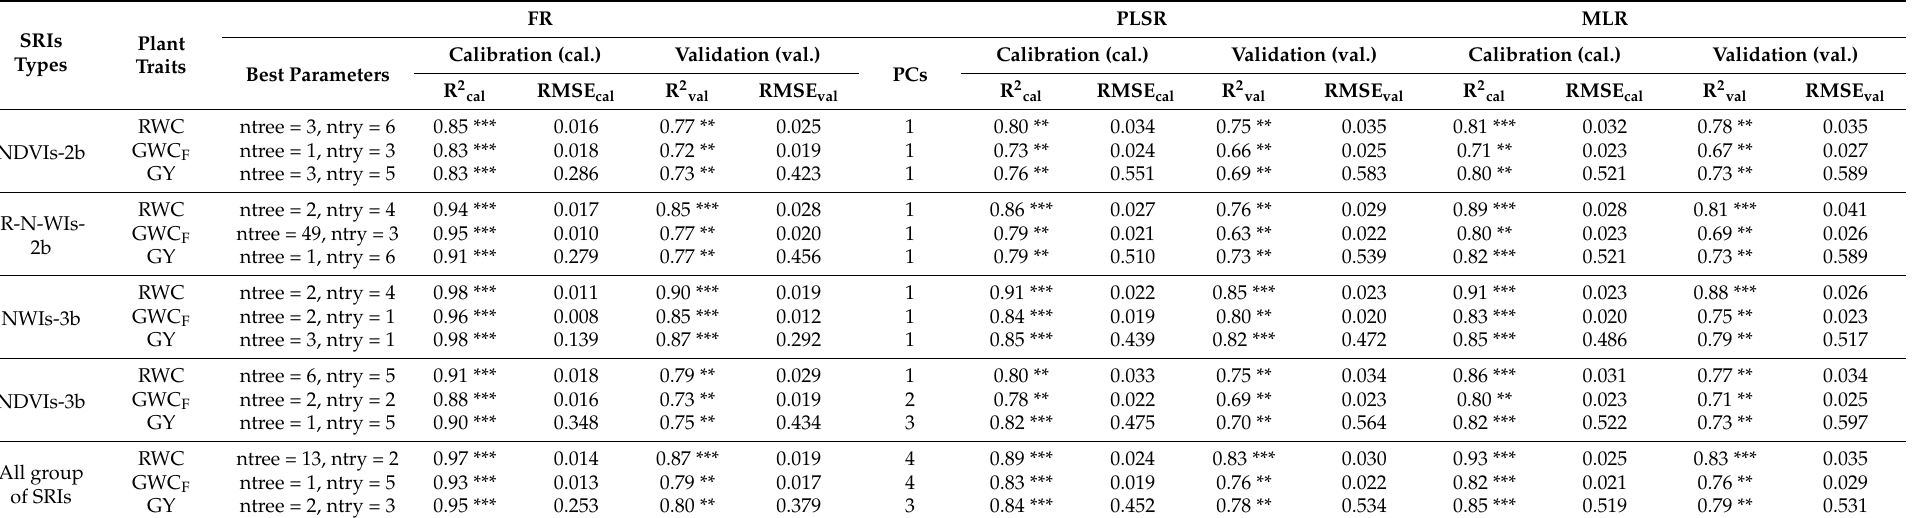
Table 4. Results of coefficient of determination (R2) and root mean square error (RMSE) of the calibration (Cal.), and ten-fold cross-validation (Val.) for the random forest (RF), partial least square regression (PLSR), and multiple linear regression (MLR) models of the relationship between the spectral reflectance index types and relative water content (RWC), gravimetric water content on a fresh weight basis (GWC F ), and grain yield (GY) of wheat cultivars across all growth conditions (cultivars, irrigation regimes, and